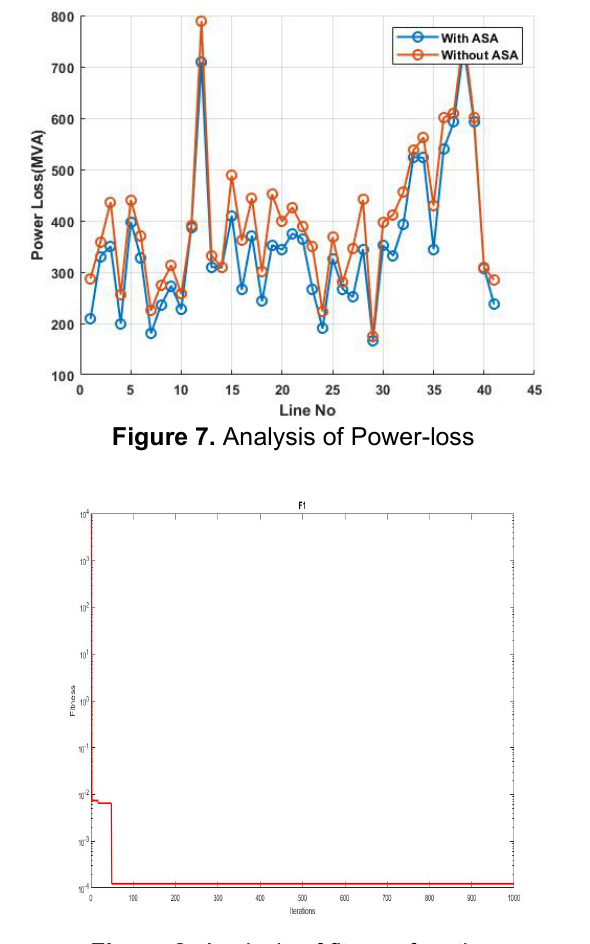
Figure 8. Analysis of fitness function